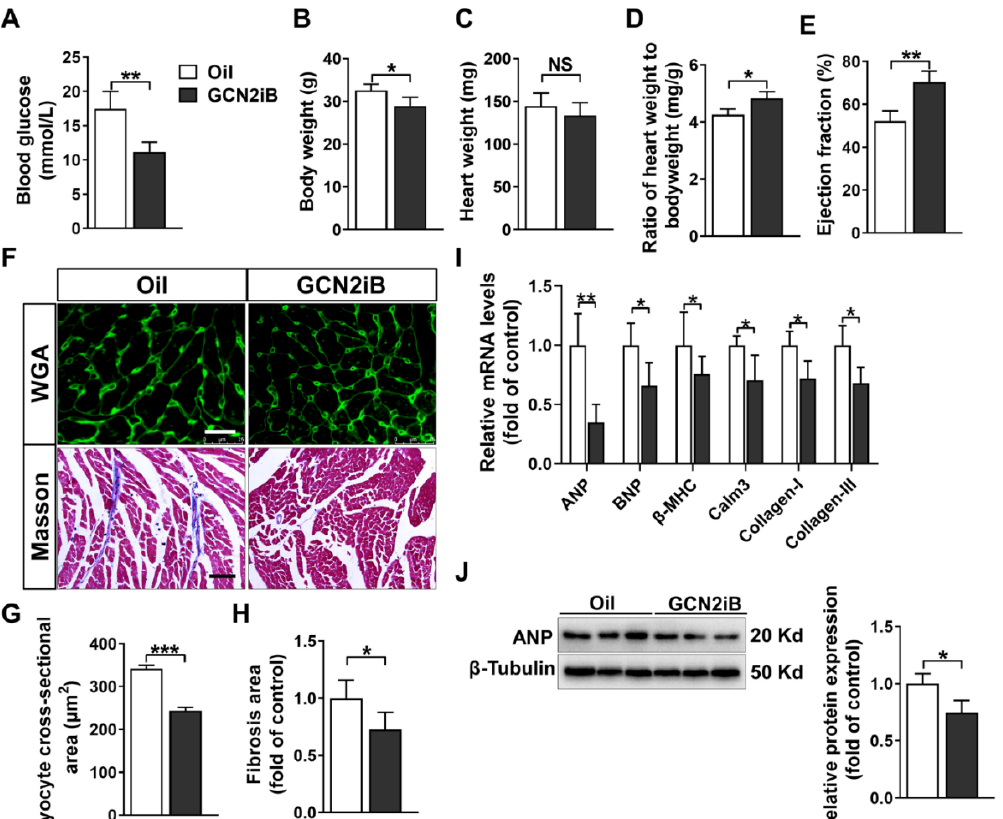
Figure 1. GCN2iB improves cardiac function and attenuates myocardial fibrosis in type 2 diabetic (T2D) mice. High-fat diet plus low-dose streptozotocin (STZ)-induced male type 2 diabetic mice were treated with oil or GCN2iB (3 mg/kg) every other day via intraperitoneal injection for 6 weeks. At the end of the experiments, fasting blood glucose levels ( A ), body weight ( B ), heart weight ( C ), the ratio of heart weight to body weight ( D ) and left ventricular ejection fraction ( E ) were measured. ( F ) Representative heart sections were stained with wheat germ agglutinin (WGA, upper panel, scale bar = 20 μ m) and Masson trichrome stain (lower panel, scale bar = 100 μ m). The myocyte cross- sectional area ( G ) and myocardial fibrosis ( H ) were quantified. ( I ) The mRNA levels of hypertrophic and fibrotic genes were measured by real-time qPCR. ( J ) Heart lysates were subjected to Western blotting to measure the expression of ANP. In Figure ( A – I ), N = 5; in Figure ( J ), N = 3; values are expressed as the means ± SD; * indicates p < 0.05; ** indicates p < 0.01; *** indicates p <